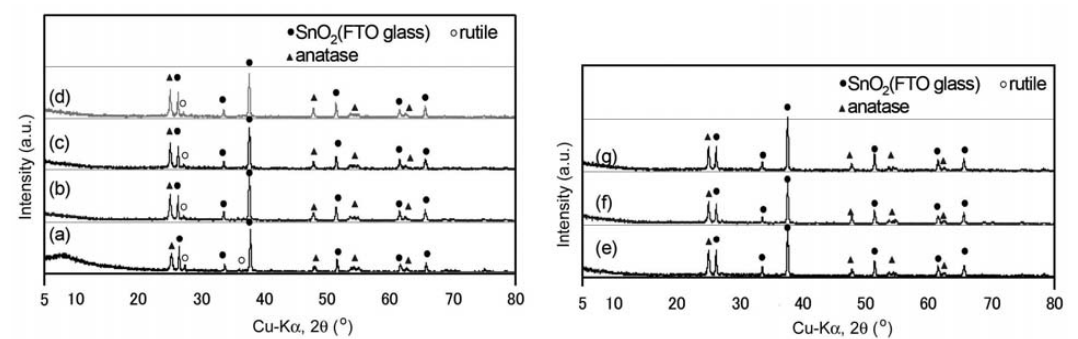
Fig. 8 XRD patterns taken from the DSC surface: TiO 2 anatase nanowire contents in the precursor paste were (a) 0 wt%, (b) 10 wt%, (c) 20 wt% (d) 30 wt%, (e) 40 wt%, (f) 50 wt% and (g) 100 wt%, respectively.